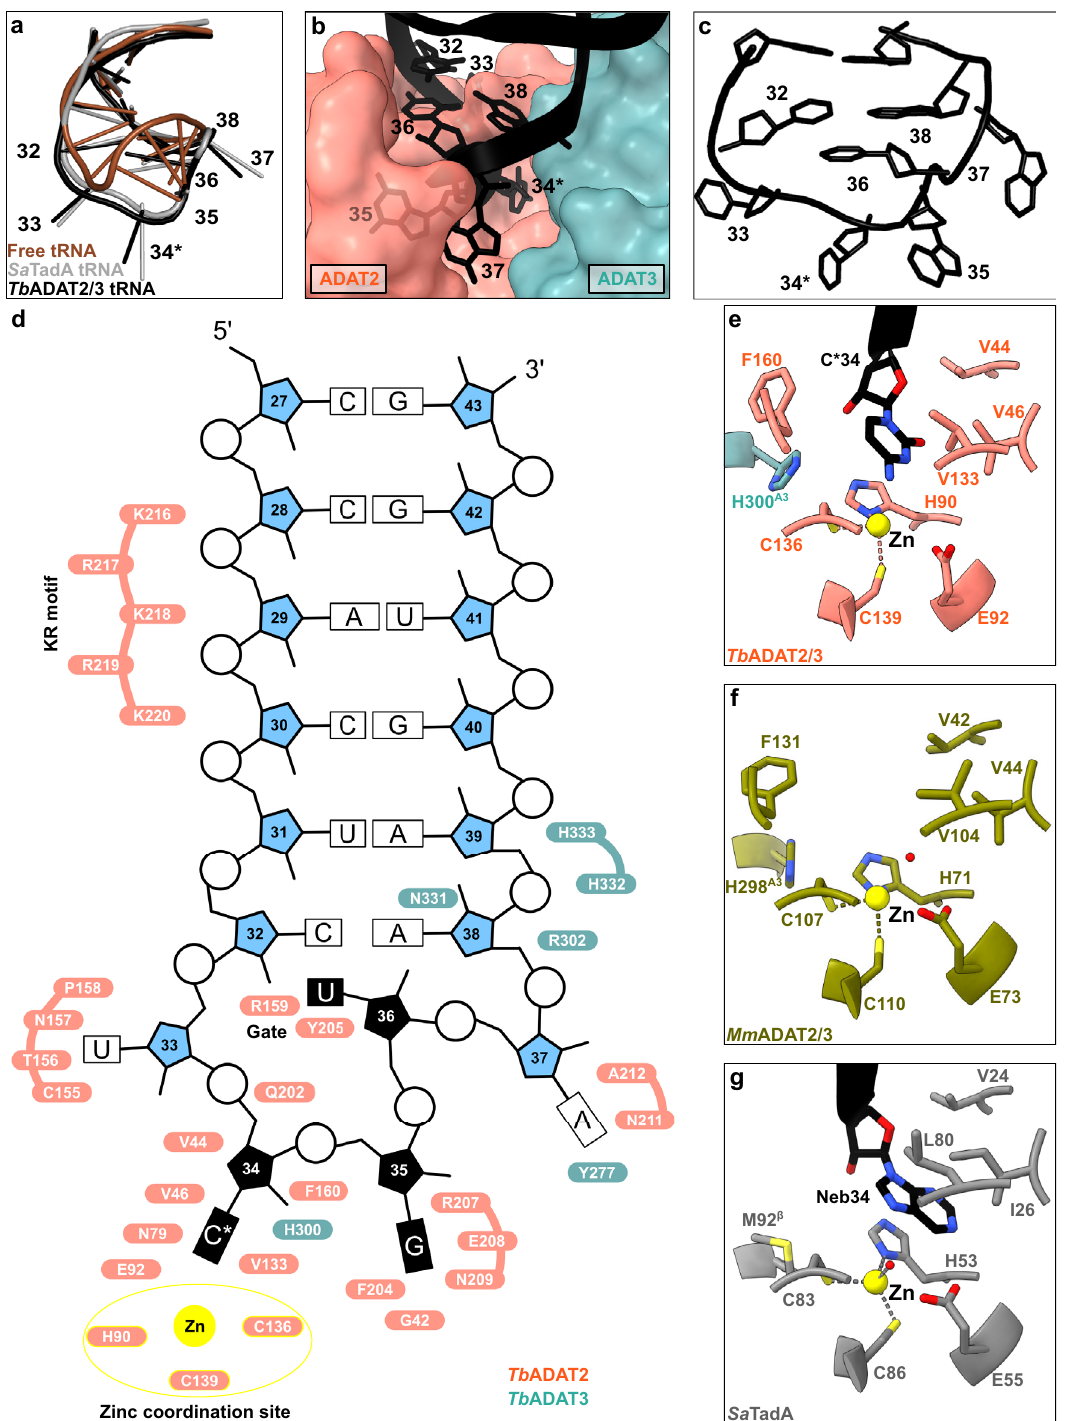
Fig. 2 | The interaction of the tRNA anticodon-stem loop with ADAT2/3. a The anticodonloop(ACL)boundto Tb ADAT2/3(black)isdistortedwithrespecttofree tRNA (brown; PDB: 1EHZ) but resembles the ACL bound to bacterial TadA (gray; PDB: 2B3J), all cartoon-stick representation. b A deep cleft in the dimer interface accommodates the ACL. Colors as in Fig. 1, ADAT2/3 model as surface repre- sentation, tRNAascartoon with anticodonloopbasesshown. c The deformedACL bound to the Tb ADAT2/3, backbone in cartoon and bases in stick representation. d Schematic overview of the anticodon stem loop (ACSL) and its interactions with